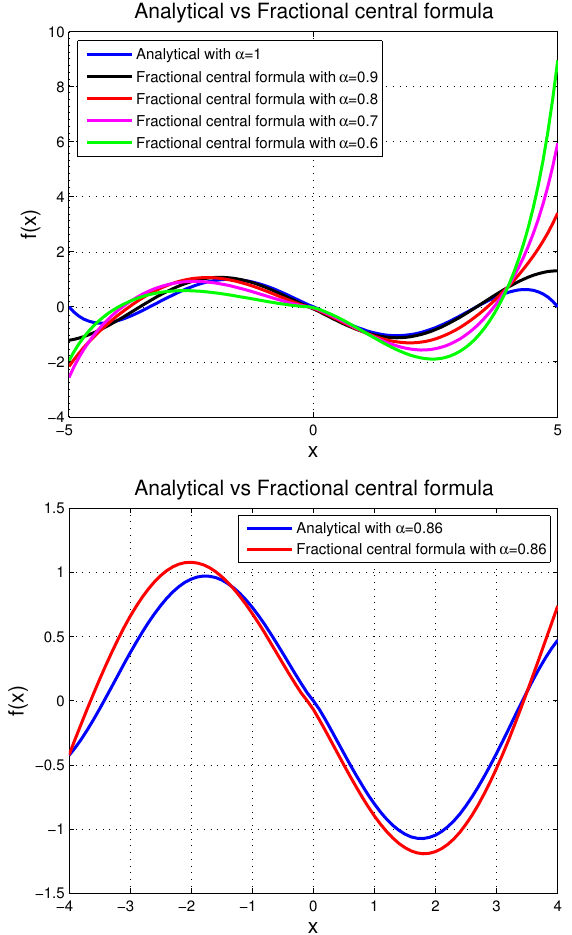
Figure 3. Comparison results between the analytical and fractional central formulas for Example